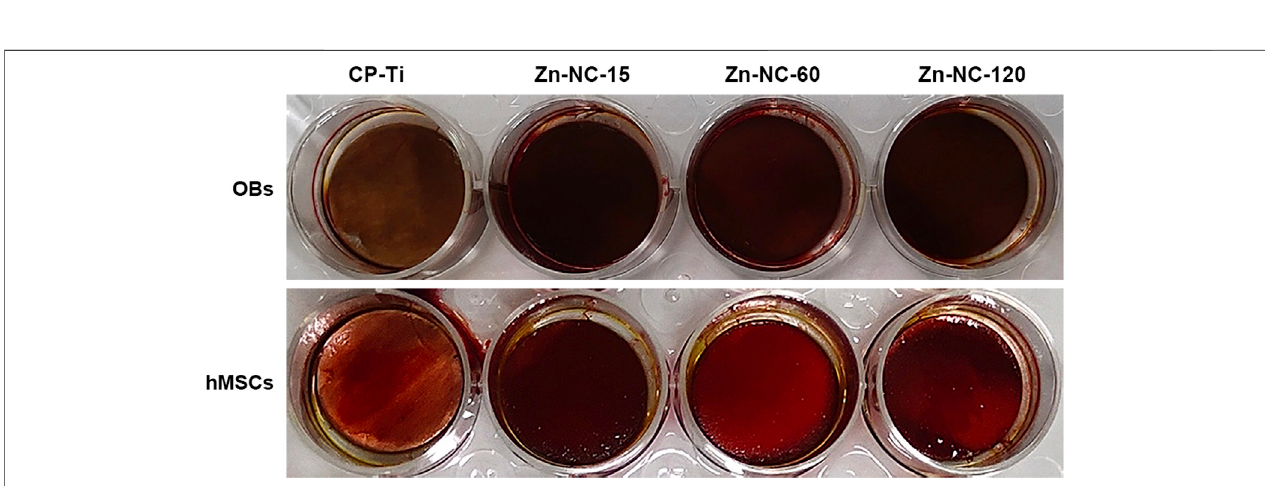
FIGURE 12 | ECM mineralization of OBs and hMSCs cultured for 21 days on the different surfaces.